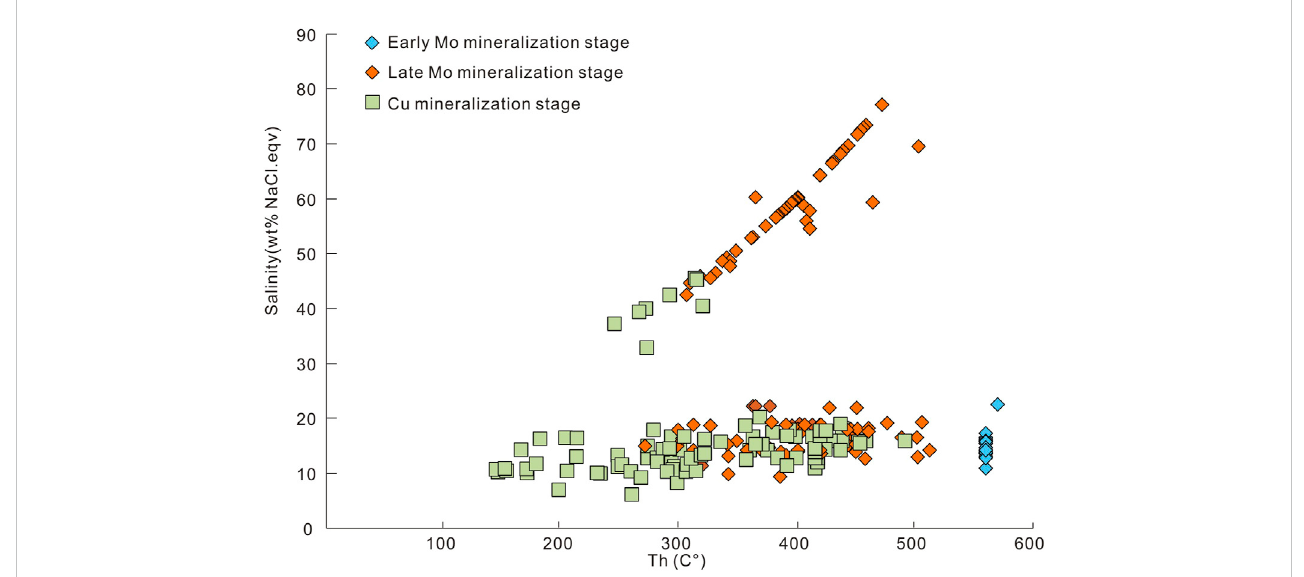
FIGURE 10 Plot of homogenization temperatures (Th) and salinity of individual fl uid inclusion in different